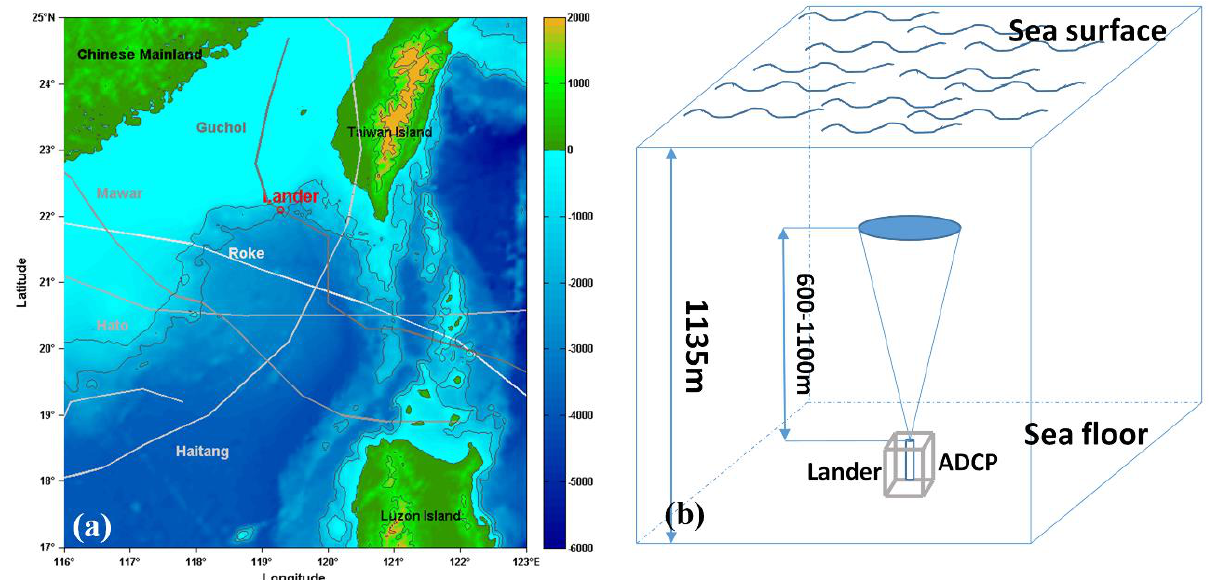
Figure 1. ( a ) Deployment of the Lander research in 2017. Lander was moored near the Luzon Strait. During the 2017 Lander component, the measurement location was approximately 177 km northwest of the strait in the sea area of the Kuroshio invasion. Lander was placed at approximately 1135 m water depth in 2017. All typhoon paths passed during the observation period are also plotted in different colors. The name of each typhoon is marked next to the typhoon track. ( b ) Schematic of acoustic Doppler current profiler (ADCP) instrumentation using during Lander data acquisition. The ADCP recorded horizontal velocities with an approximately 8 m vertical